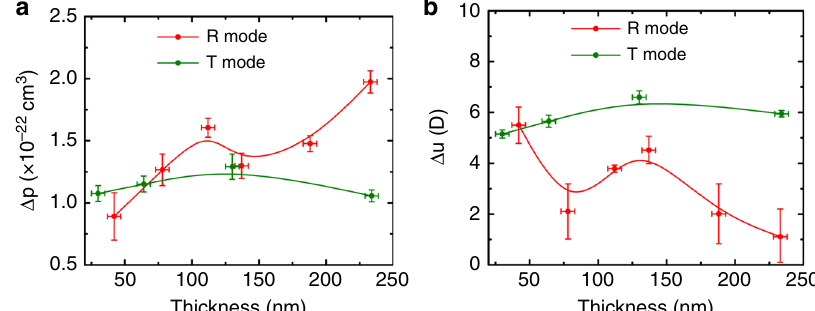
Fig. 4 Δ p and Δ u values obtained by device absorbance fi t vs. active layer thickness. The error bar in the x-axis represents the statistical standard deviation ±5 nm of the thickness determined by the pro fi lometer. The error bar in the y -axis represents the statistical standard deviation of the possible fi tting values. a Comparison of Δ p extracted from device absorbance fi t vs. thickness between re fl ection mode and transmission mode. b Comparison of Δ u extracted from device absorbance fi t vs. thickness between re fl ection mode and transmission